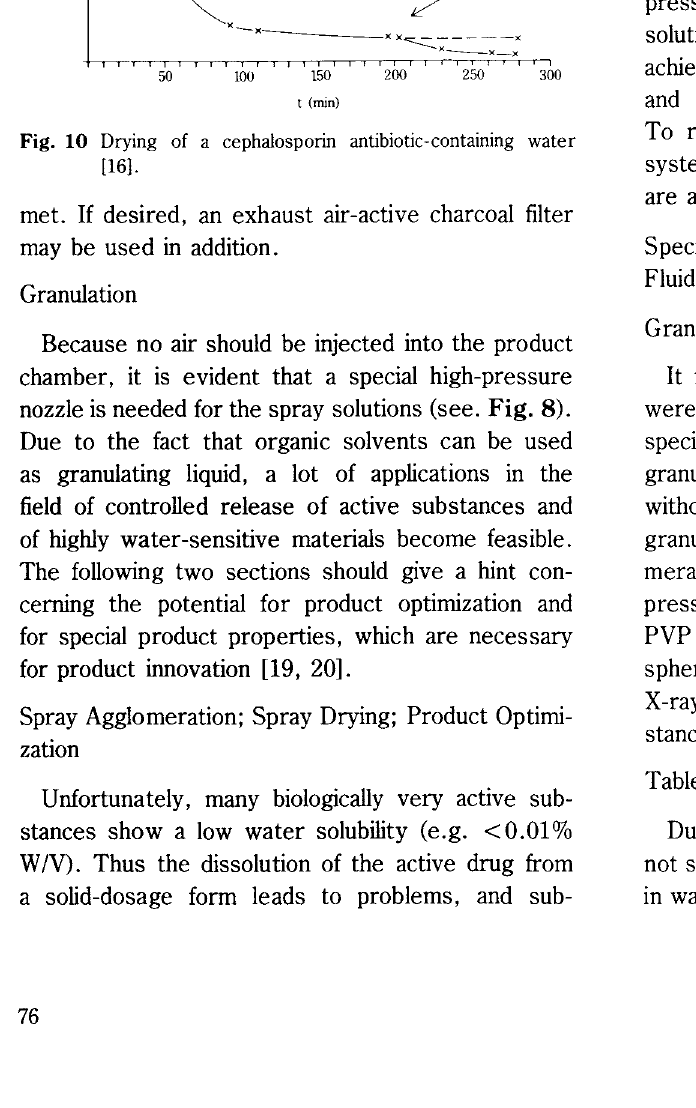
Fig. 9 Drying of an enol ester compound (solvent ethyl acetate) [16].